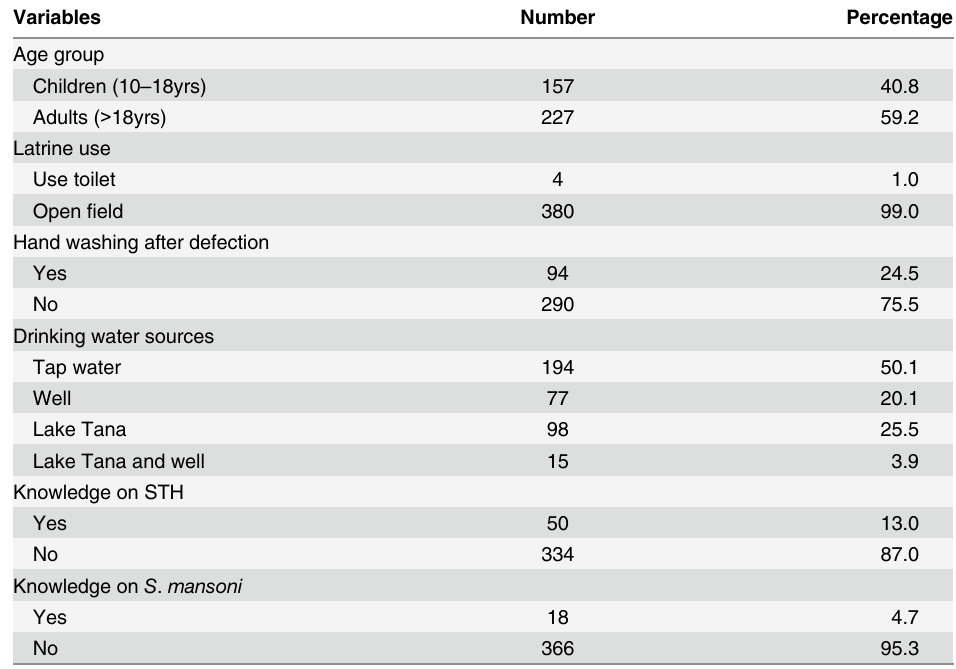
Table 1. Age and hygiene characteristics of students in Ethiopian Orthodox